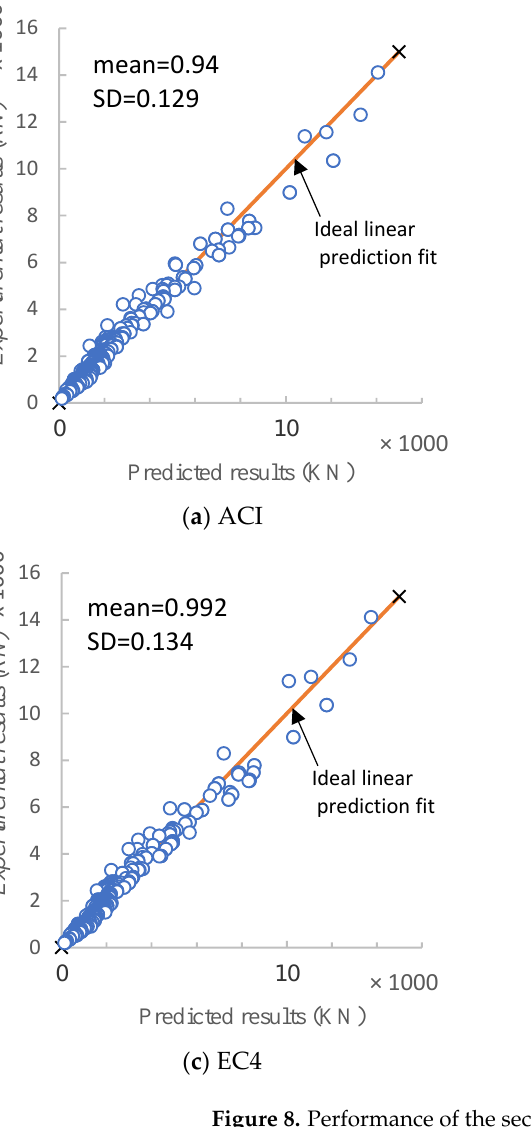
Figure 9. Comparison between the coefficient of variation of the existing and the proposed design approaches. Table 2. Comparisons of square and rectangular CFT stub column capacity produced using differ- ent equations with the experimental results. Mean